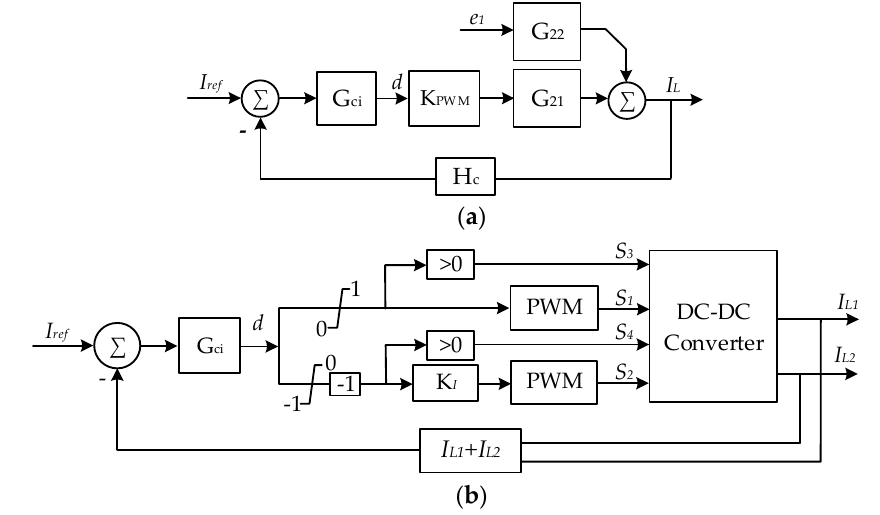
Figure 12. Current controller block diagram of the proposed converter. ( a ) Closed-loop small-signal model based on the discharge mode parameters for reference; ( b ) plant model.